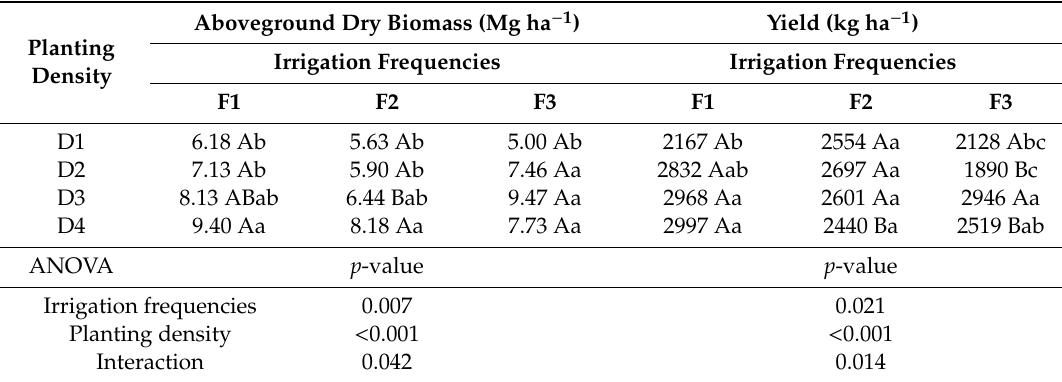
Table 6. Aboveground dry biomass of plants and bean’s grain yield as a function of di ff erent irrigation frequencies and planting densities.